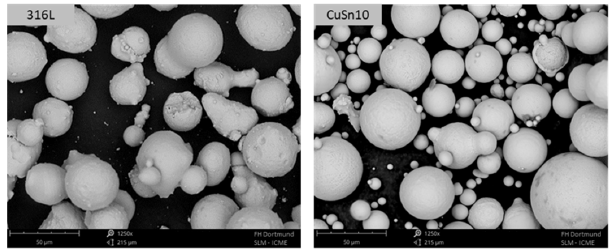
Figure 1. SEM images of the as-received powders 316L and CuSn10.